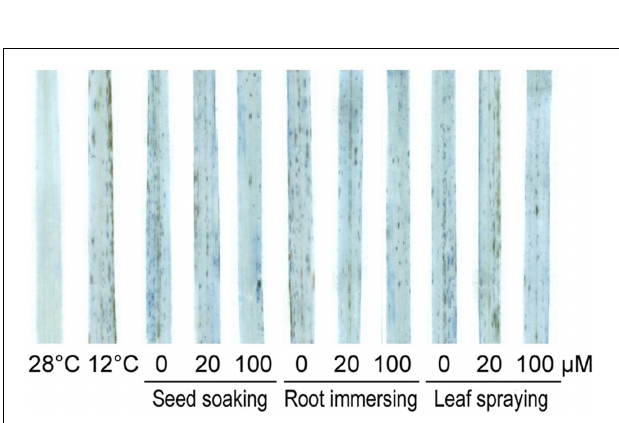
FIGURE 4 | Trypan-blue staining of control and 6-day cold treatment seedlings. Others are the same as in Figure 1 .